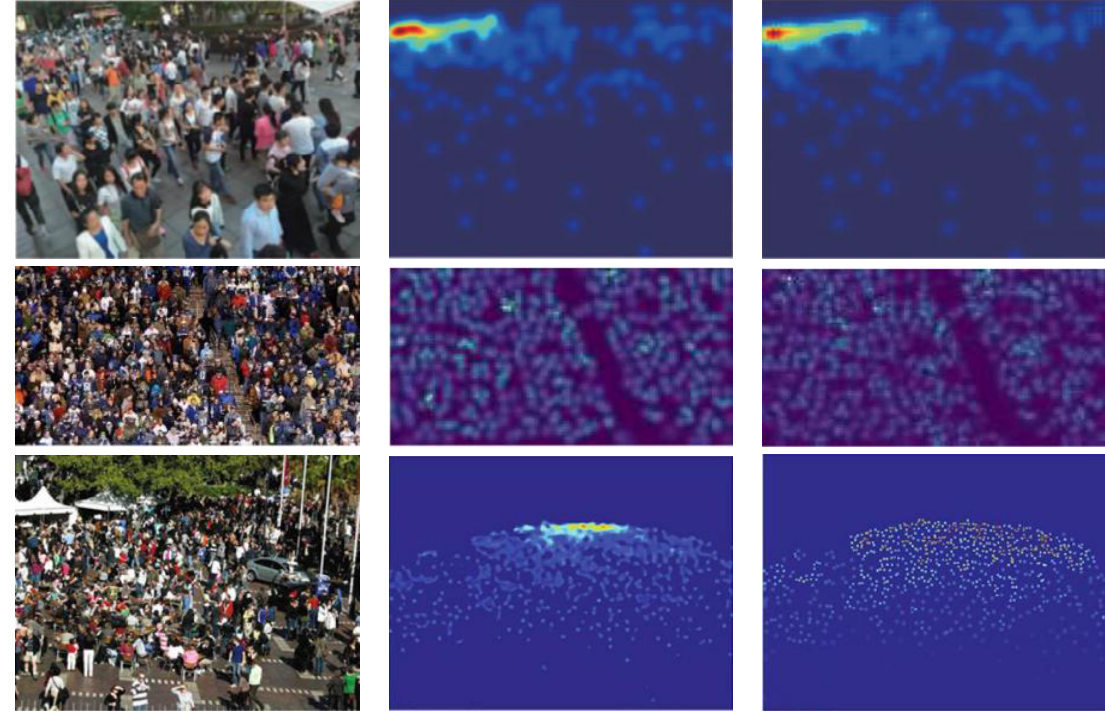
Fig. 7. Experimental results from the ShanghaiTech dataset. The first column represents the original image; The second column represents the truth graph; The third column represents the predicted result.